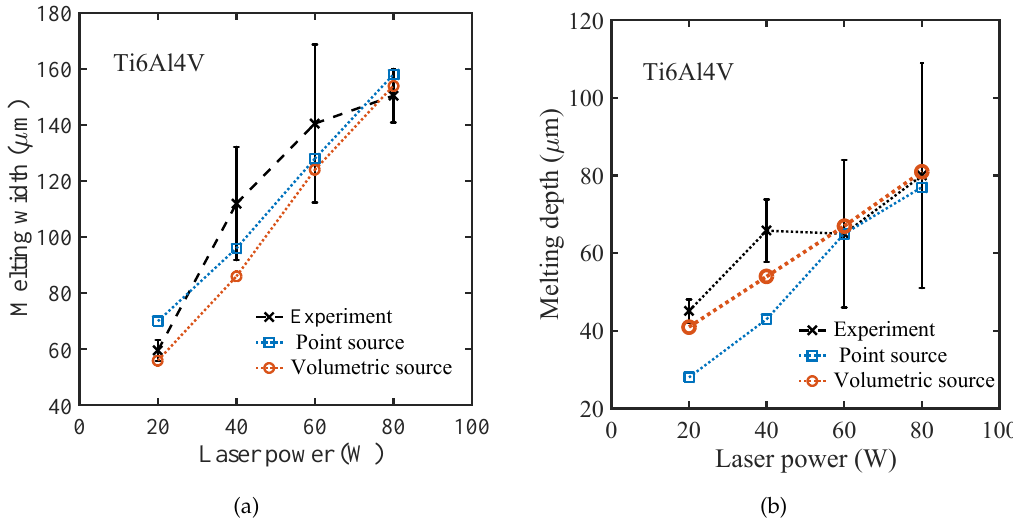
Figure 10. The predicted melt-pool ( a ) width and ( b ) depth with the experimental measurements.